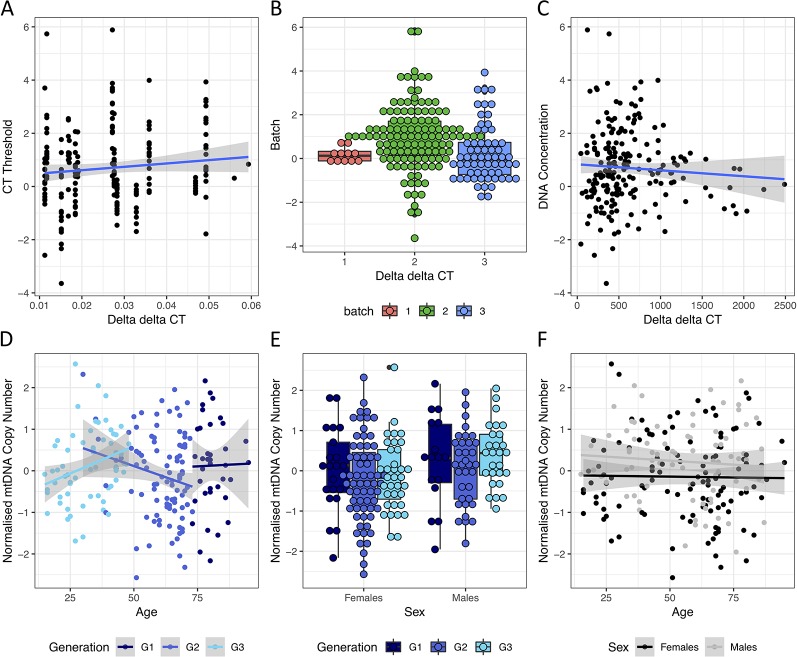
Effects of technical and biological covariates on mtDNA copy number measurements. (A) Relationships between ΔΔCT values, representing raw mtDNA copy number measures from qPCR, and the threshold CT values for each qPCR run. (B) Boxplot of ΔΔCT values from each qPCR batch. (C) Relationship between ΔΔCT values and starting DNA concentration (before dilution) of each sample. (D) Relationship between normalized mtDNA copy number measure (after correcting for threshold CT values, qPCR batch and starting DNA concentration) and age in individuals from G1, G2 and G3 in navy, blue and cyan respectively. (E) Boxplot of normalized mtDNA copy number in female and male individuals from G1, G3 and G3 in navy, blue and cyan respectively. (F) Relationship between normalized mtDNA copy number and age in females (in black) and males (in grey) respectively.